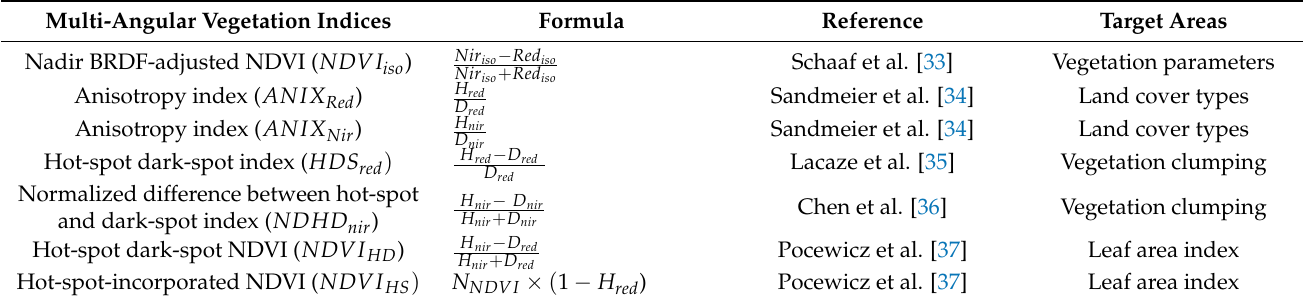
Table 1. Overview of the multi-angular vegetation indices available in the literature. The iso, H, N, and D refers to the configuration of the sun-sensor geometries at Nadir-sun Nadir-view, Hot-spot, Nadir, and Dark-spot, respectively. Multi-Angular Vegetation Indices Formula Reference Target Areas Schaaf et al. [33] Vegetation parameters Nadir BRDF-adjusted NDVI ( NDVI iso ) Nir iso − Red iso Nir iso + Red iso Anisotropy index ( ANIX Red ) H red Sandmeier et al. [34] Land cover types D red Anisotropy index ( ANIX Nir ) H nir Sandmeier et al. [34] Land cover types D nir Hot-spot dark-spot index ( HDS red ) H red − D red Lacaze et al. [35] Vegetation clumping D red Normalized difference between hot-spot H nir − D nir Chen et al. [36] Vegetation clumping H nir + D nir and dark-spot index ( NDHD nir ) Hot-spot dark-spot NDVI ( NDVI HD ) H nir − D red Pocewicz et al. [37] Leaf area index H nir + D red Hot-spot-incorporated NDVI ( NDVI HS ) N NDVI × ( 1 − H red ) Pocewicz et al. [37] Leaf area